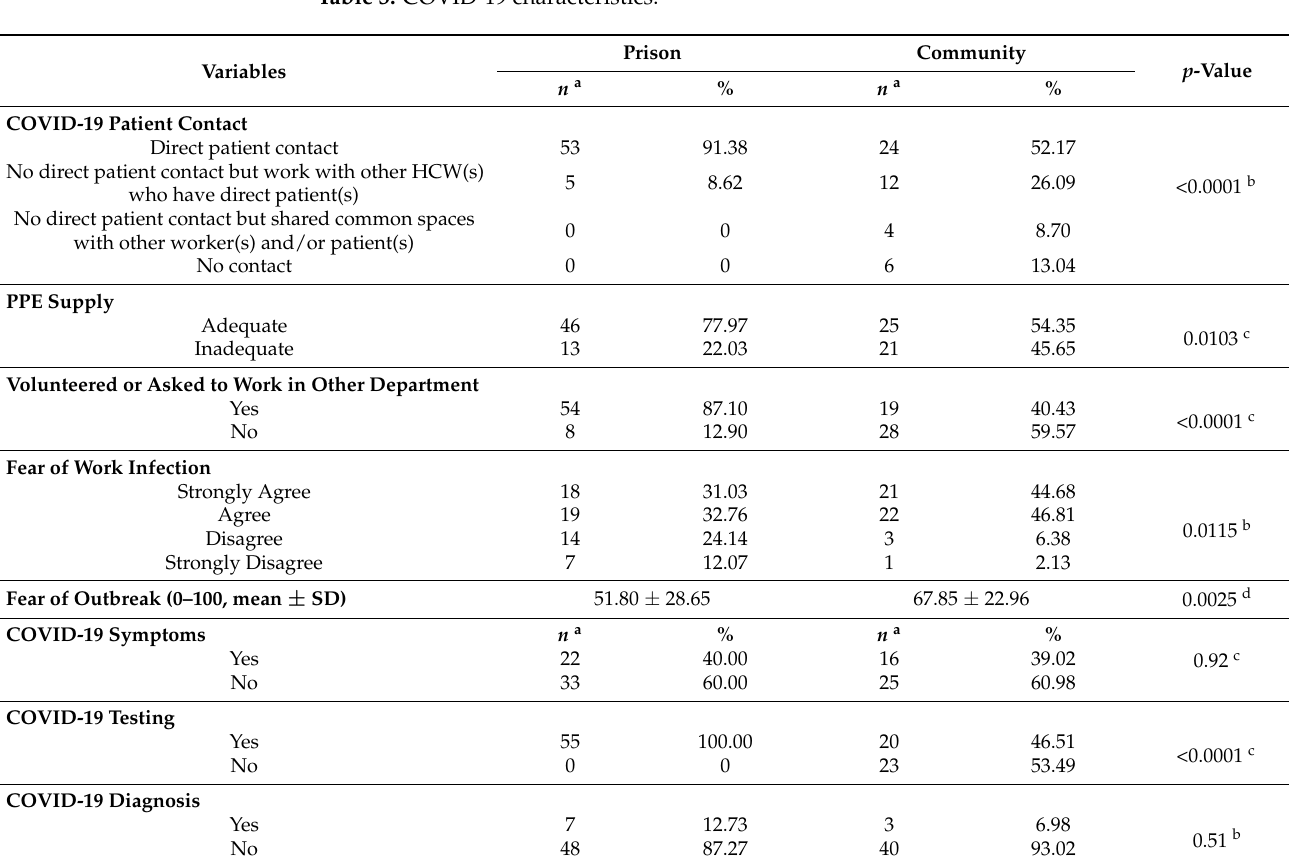
Table 3. COVID-19